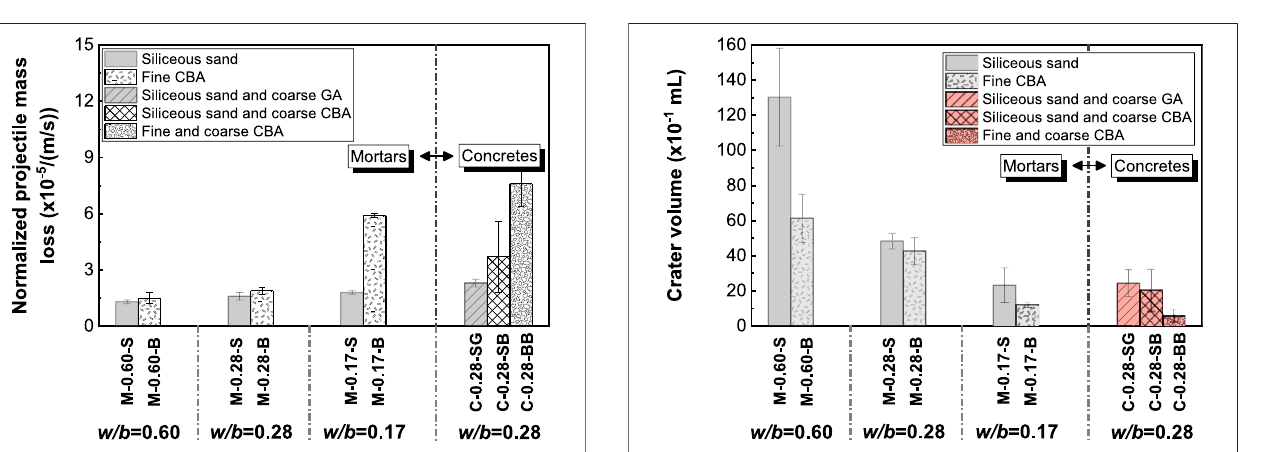
FIGURE 11 | Effect of CBA on the normalized mass loss of deformable copper projectile.